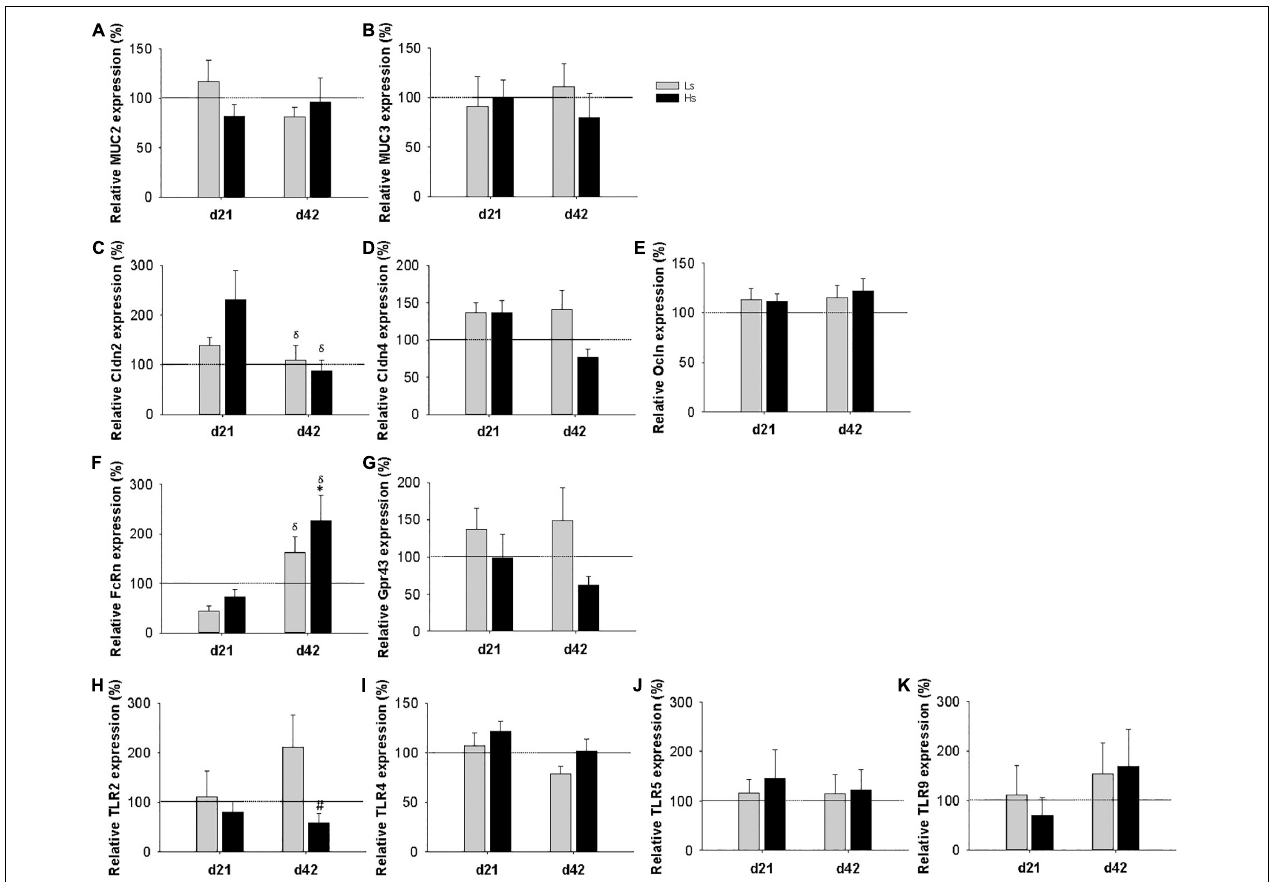
FIGURE 5 | Intestinal gene expression of mucin (MUC) 2 (A) and MUC 3 (B) , claudin (Cldn) 2, Cldn4 ( C,D , respectively), occludin (Ocldn) (E) , FcRn (F) , Gpr43 (G) , and Toll like receptors (TLR) 2 (H) , TLR4 (I) , TLR5 (J) , TLR9 (K) at days 21 and 42. Relative gene expression was calculated with respect to REF animals, which corresponded to 100% of transcription. Results are expressed as mean ± S.E.M ( n = 9 animals/group). Statistical significance: ∗ p < 0.05 vs. REF, # vs. Ls. REF and δ day 42 vs. day 21: reference group; Ls, group supplemented with low dose of S. epidermidis and Hs, group supplemented with high dose of S. epidermidis